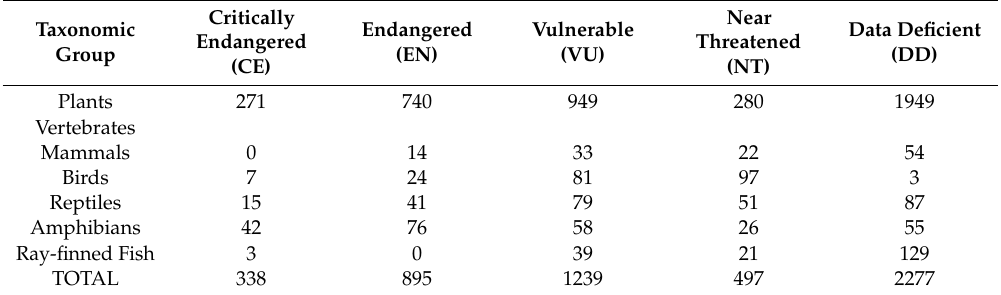
Table 7. Number of threatened plants and vertebrate taxa in Ecuador according to IUCN threat categories (IUCN